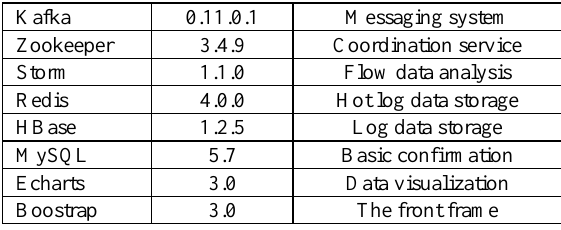
Table 2. Development environment